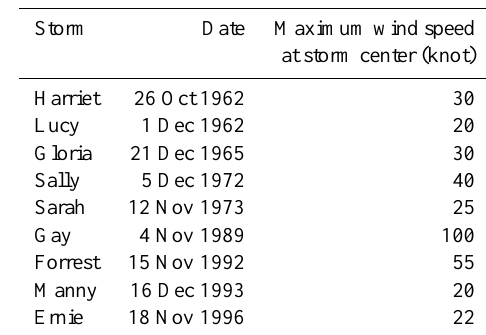
Table 1. History of nine tropical storms and typhoons that ap- proached within a 180-nautical-mile radius of Phuket during the 52-year period (1945–1996). Modified from the Typhoon Havens Handbook (Brand,